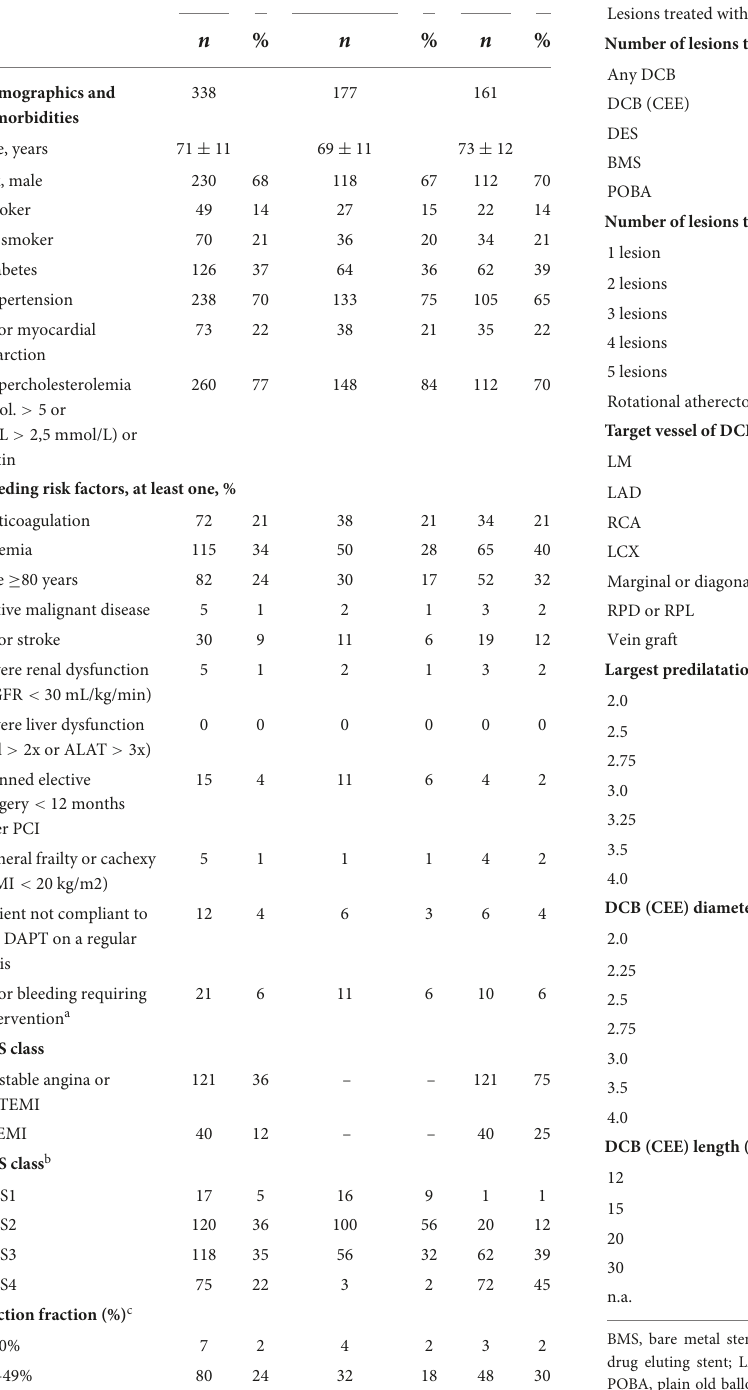
TABLE 2 Baseline characteristics of percutaneous coronary intervention (PCIs) and